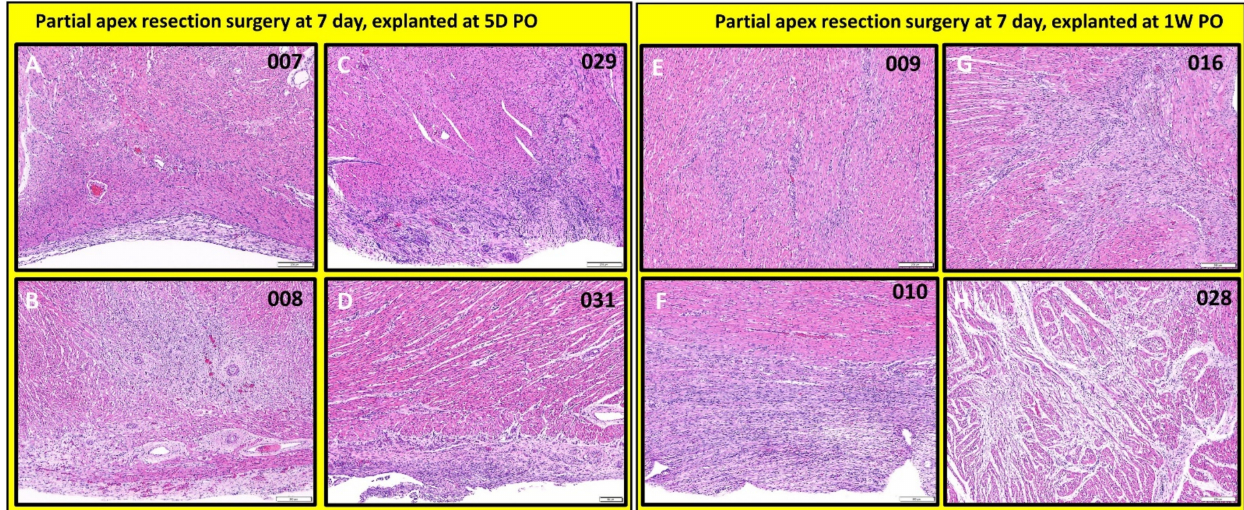
Figure 15. Partial apex resection surgery at seven days and heart explants at 5D PO and 1W PO- Hematoxylin and Eosin (H & E) histology of seven-day surgery heart explants obtained five days post-operation (5D PO): ( A ) Seven-day surgery heart from piglet #007. ( B ) Seven-day surgery heart from piglet #008. ( C ) Seven-day surgery heart from piglet #029. ( D ) Seven-day surgery heart from piglet #031. H & E histology of seven-day surgery heart explants obtained one-week post-operation (1W PO): ( E ) Seven-day surgery heart from piglet #009. ( F ) Seven-day surgery heart from piglet #010. ( G ) Seven-day surgery heart from piglet #016. ( H ) Seven-day surgery heart from piglet #028. Histological images were taken at 4 × magnification (Scale bar = 200 µ m). H & E: pink–cytoplasm; blue–nuclei; intense